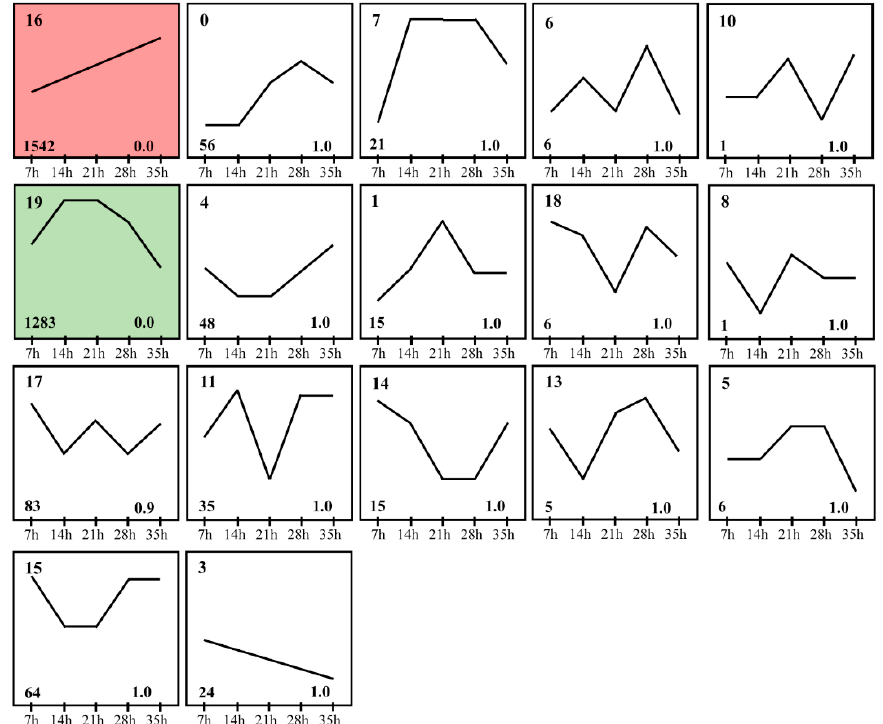
Figure 3. Differential expression clusters of differential expression genes in different developmental time points (7 h, 14 h, 21 h, 28 h and 35 h). Significant expression profiles ( p < 0.05) of differential expression genes clustered via STEM software in different developmental time points. The numbers in the left upper part of boxes are profile serial numbers, those in left lower part are p -values, and those in the right lower part are numbers of transcripts contained in profiles.